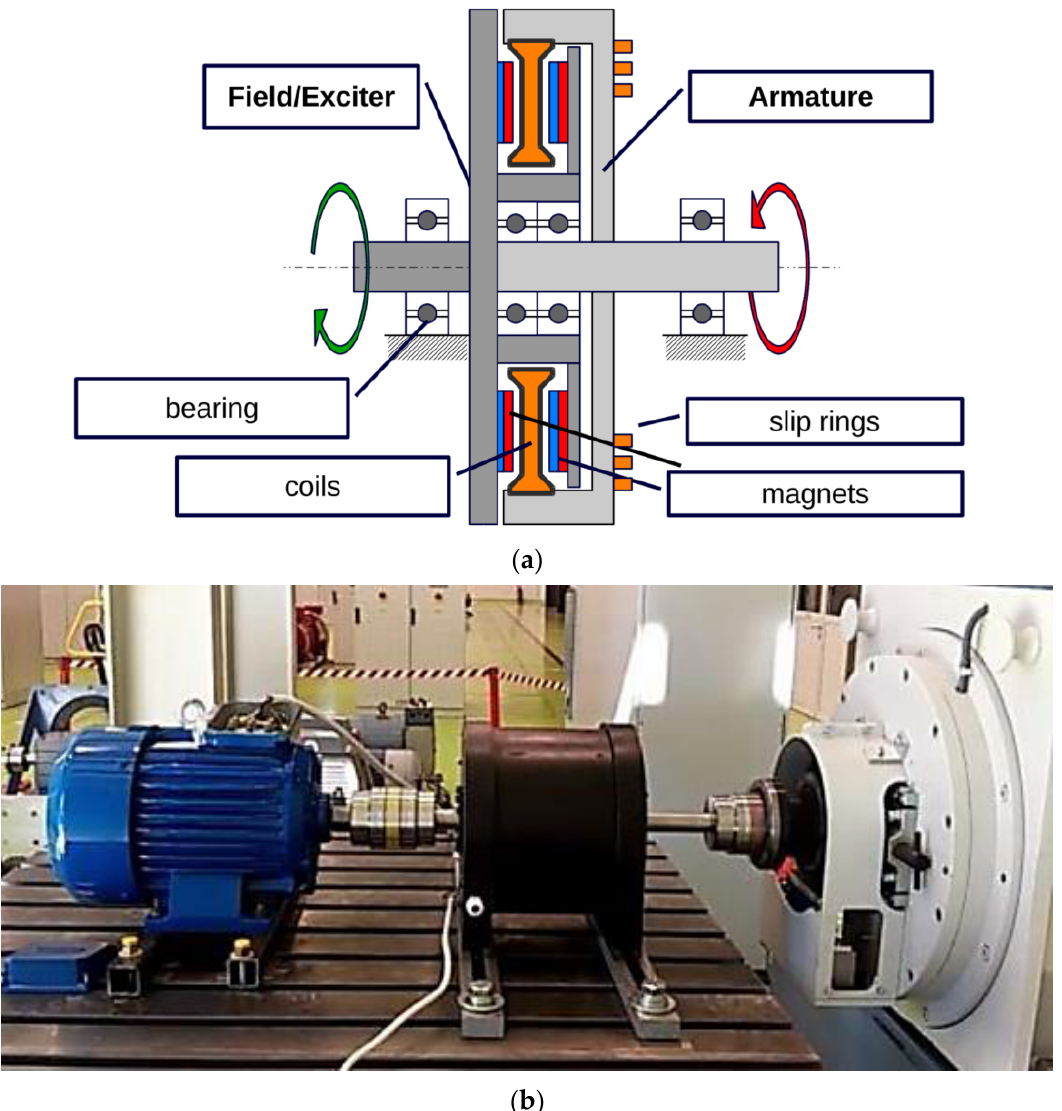
Figure 8. ( a ) Axial-flux permanent magnet dual-rotor generator. ( b ) Laboratorial setup [17].